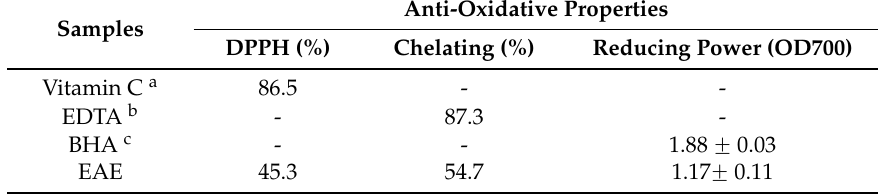
Table 1. Antioxidative properties of enriched astaxanthin extract (EAE) at 10 µ g/mL on various assay plates. (-), no testing; DPPH: 1,1-Diphenyl-2-Picrylhydrazyl; EDTA: Ethylenediaminetetraacetic acid; BHA: Butylated hydroxyanisole. Anti-Oxidative Properties Samples DPPH (%) Chelating (%) Reducing Power (OD700) Vitamin C